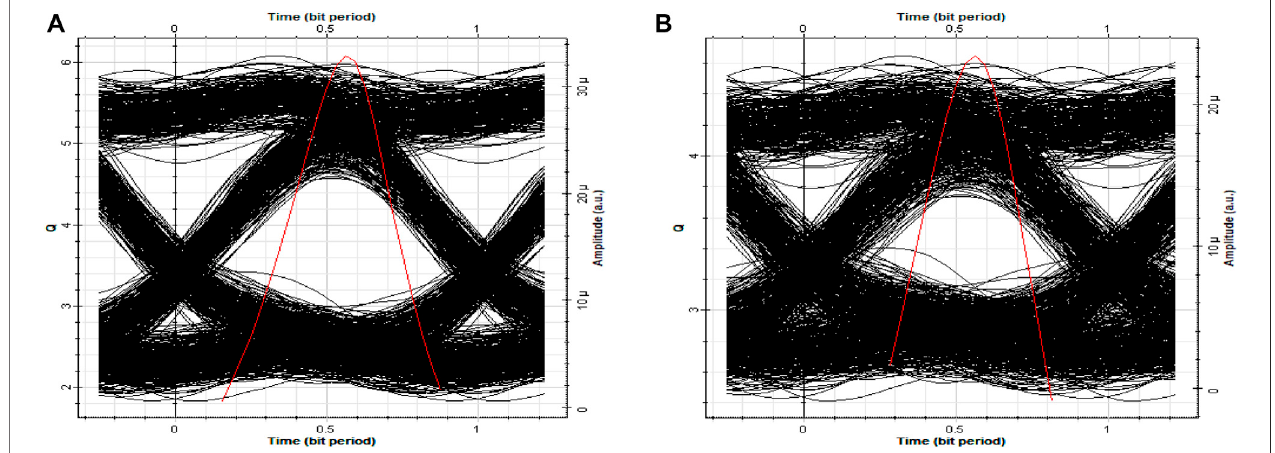
FIGURE 6 | Eye diagram using the proposed NRZ-based MDM-RoFSO system at 2,500 m transmission distance under very light dust for the (A) HG00 channel and (B) HG01 channel.